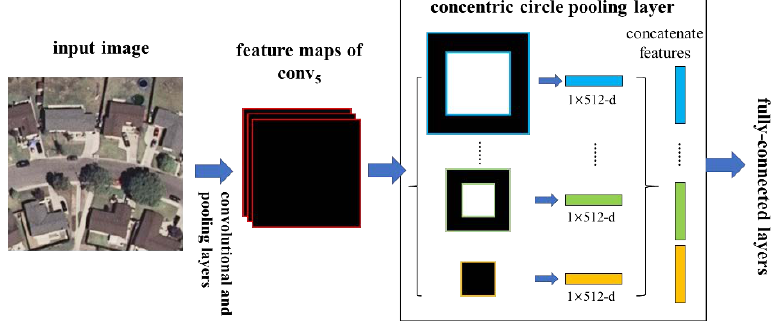
Figure 4. A network structure with a concentric circle pooling layer. The convolutional and pooling layers except for the last pooling layer in VGG-VD16 are transformed to this network and 512 is the filter number of the conv 5 layer, which is the last convolutional layer.